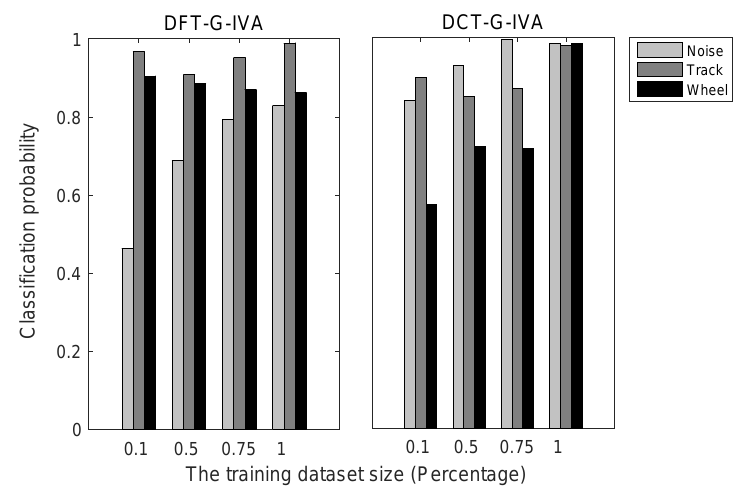
Figure 7. Classification probabilities of each target type using G-IVA on the training sets with different sizes.